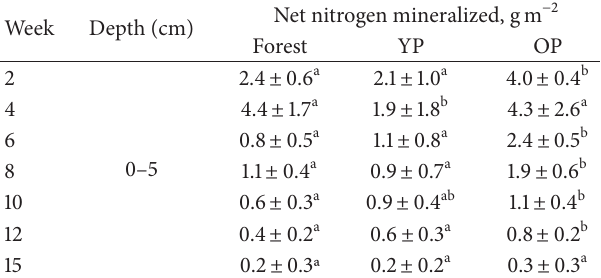
Table 7: Net nitrogen mineralized by week throughout 15 weeks of incubation in the soil forest and pastures.